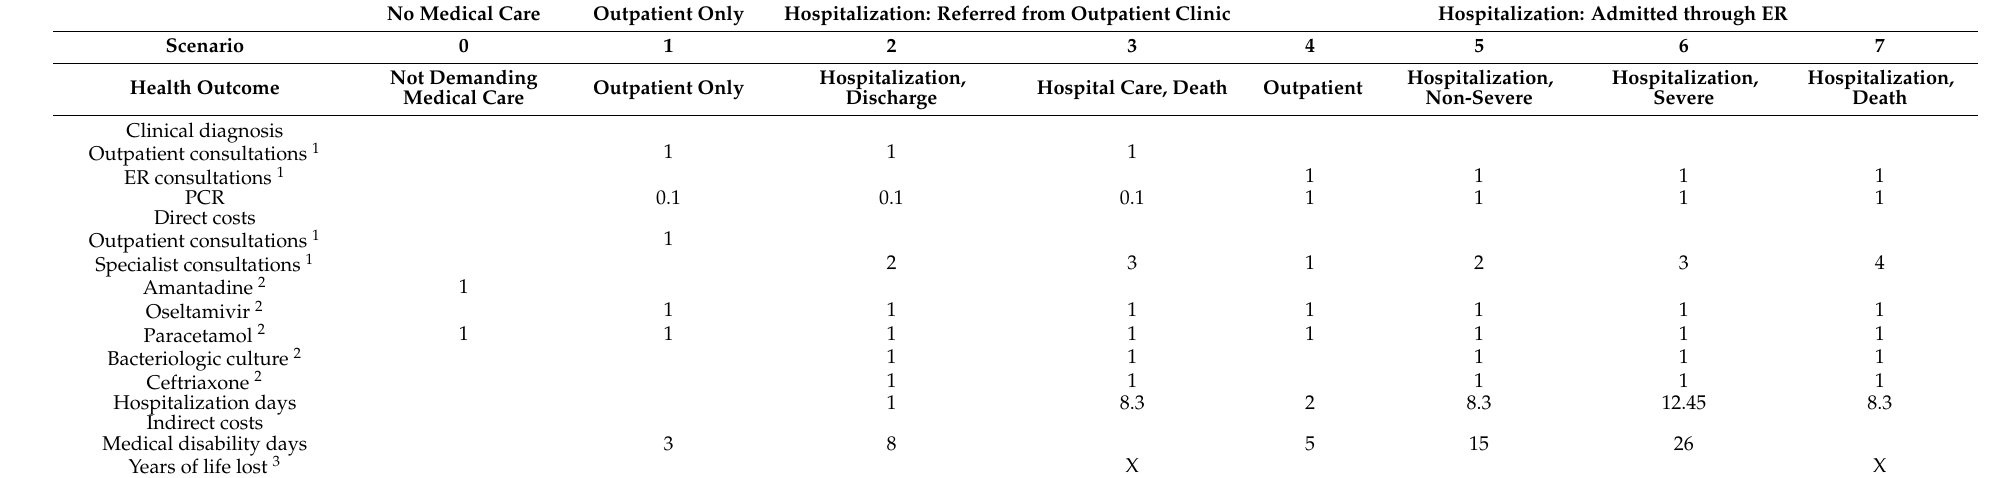
Table 1. Clinical management by